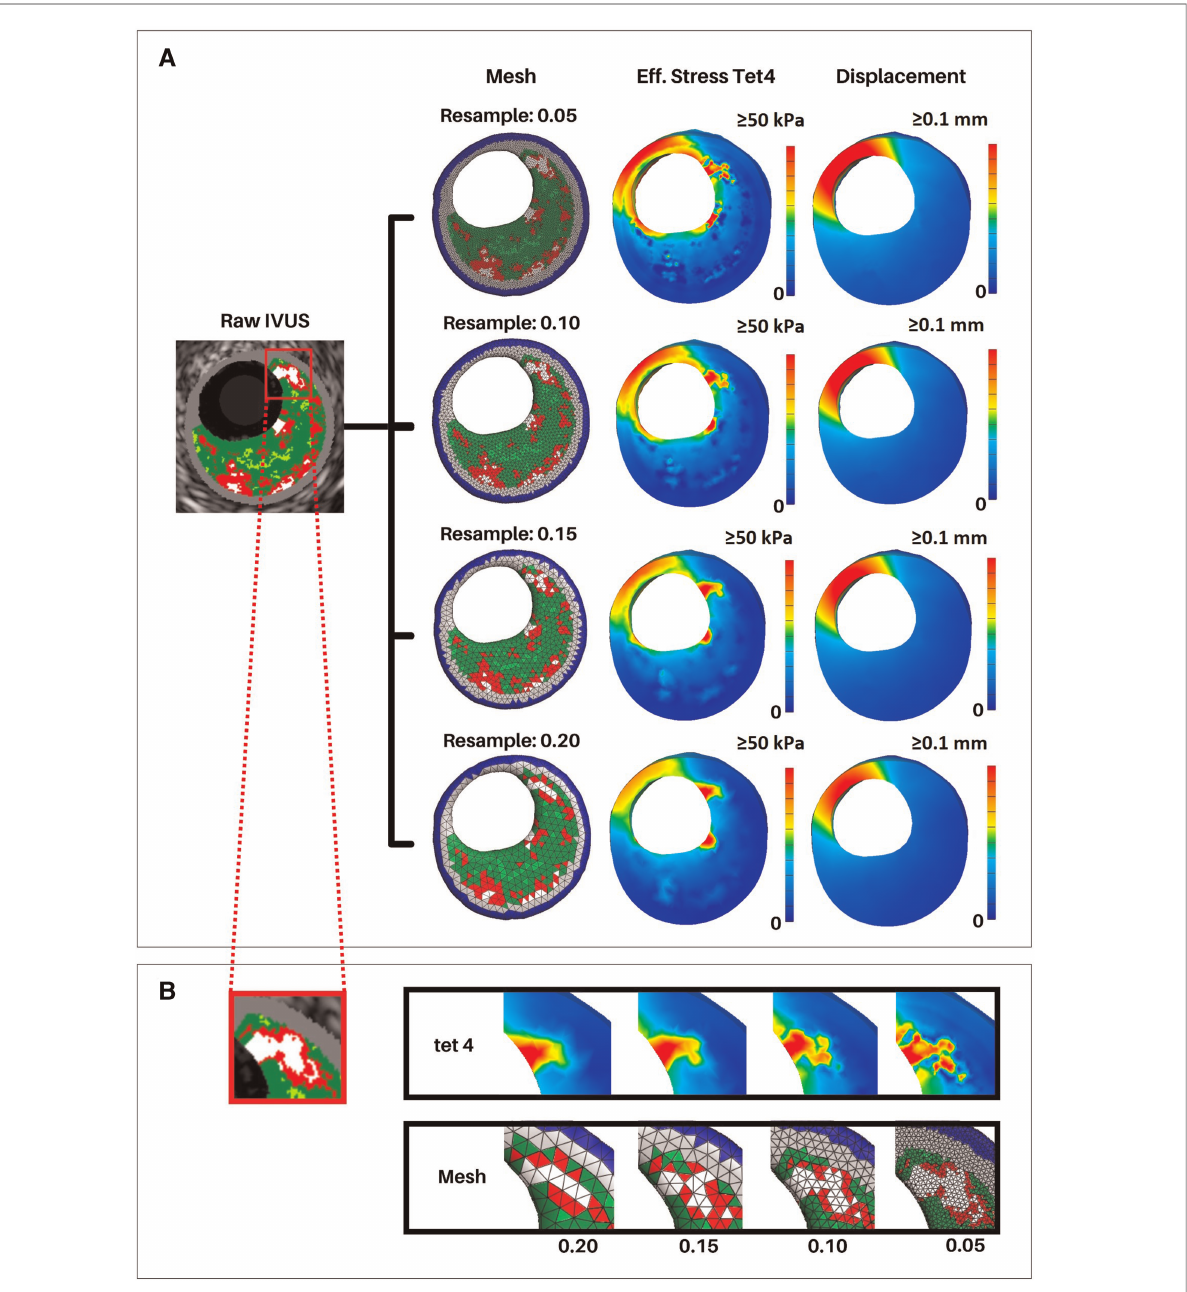
FIGURE 7 Effective stress and displacement with varying mesh resolutions. Arterial meshes of a short 5 VH-IVUS slice artery segment were reconstructed at resolutions of 0.05, 0.1, 0.15, and 0.2 mm. Similar simulation parameters were used in all meshes to calculate effective stress and displacement in FEBio. ( A ) First column shows the middle slice of the reconstructed meshes. Second and third columns show cross-sectional views of the effective stress and displacement, respectively. ( B ) Close-up view of a calci fi ed region of the middle VH-IVUS image and corresponding regions of the arterial mesh. The top row shows effective stress, and the bottom row shows the mesh at each